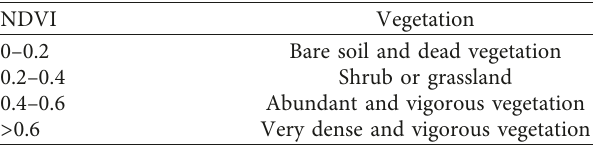
∗ Provided by the Mapping and Geological Institute of Catalonia